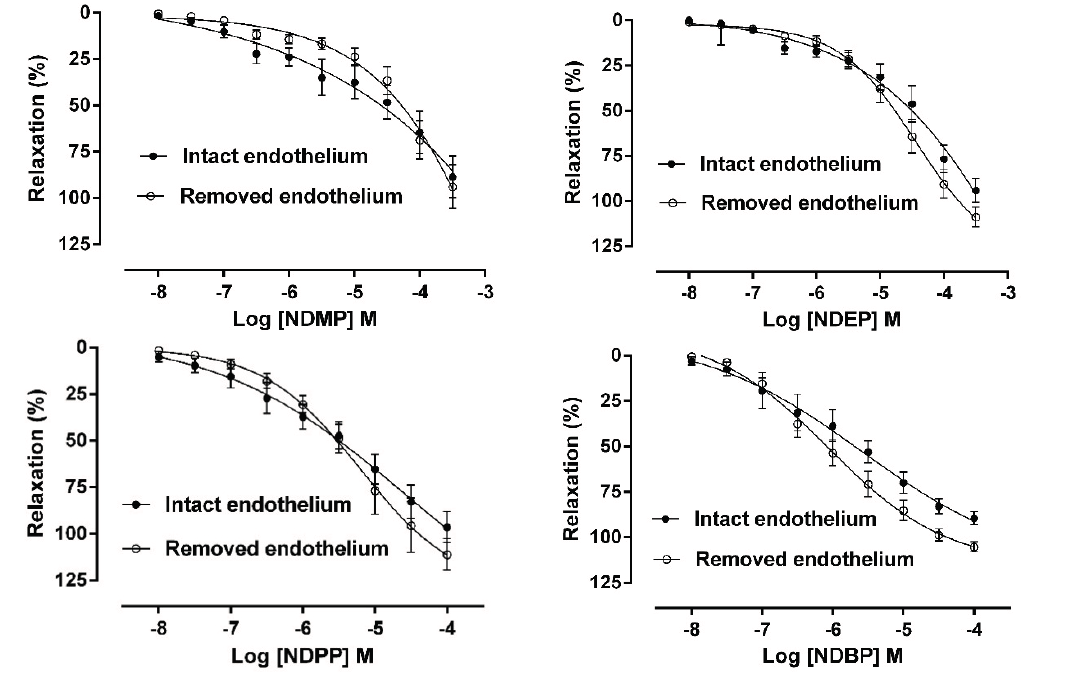
Figure 2. Concentration-response curves to new organic nitrates synthetized by our group (10 − 8 –10 − 4 M or 3 × 10 − 4 M) in rat mesenteric artery rings (n = 6 per group). The vasorelaxant effect is expressed as a percentage of relaxation of phenylephrine-induced contraction